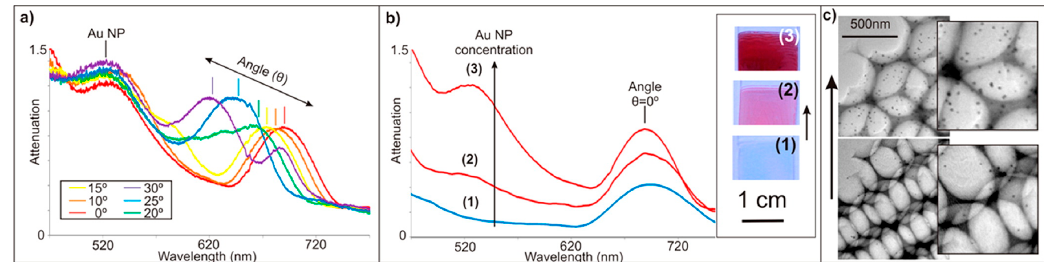
nanoparticles (NPs) via a co-self-assembly method combined with subsequent removal of